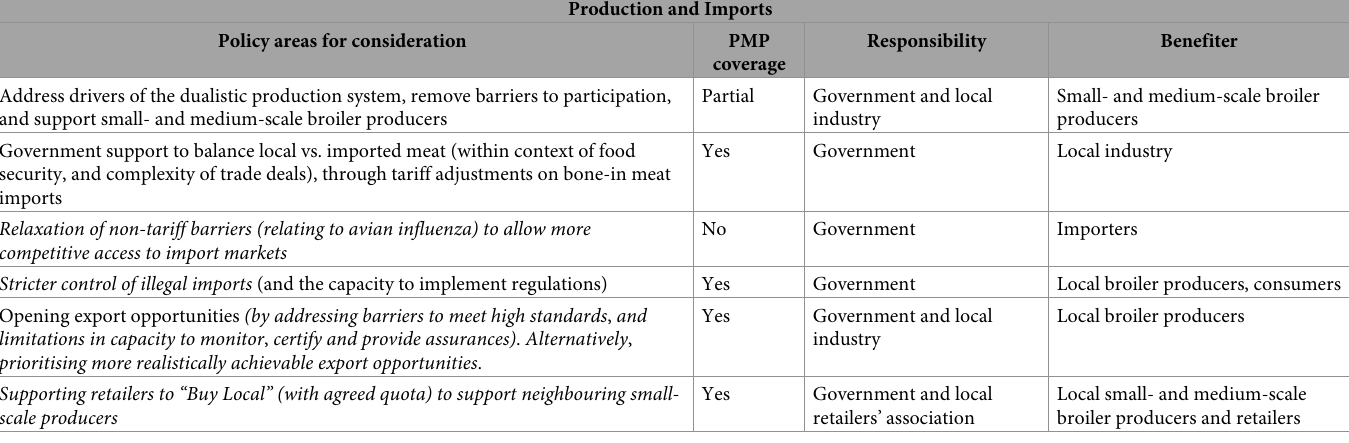
Table 1. Summary of production and imports policy areas for consideration. Original ideas presented in meetings are in plain font, and stakeholder additions in italics (PMP = Poultry Master